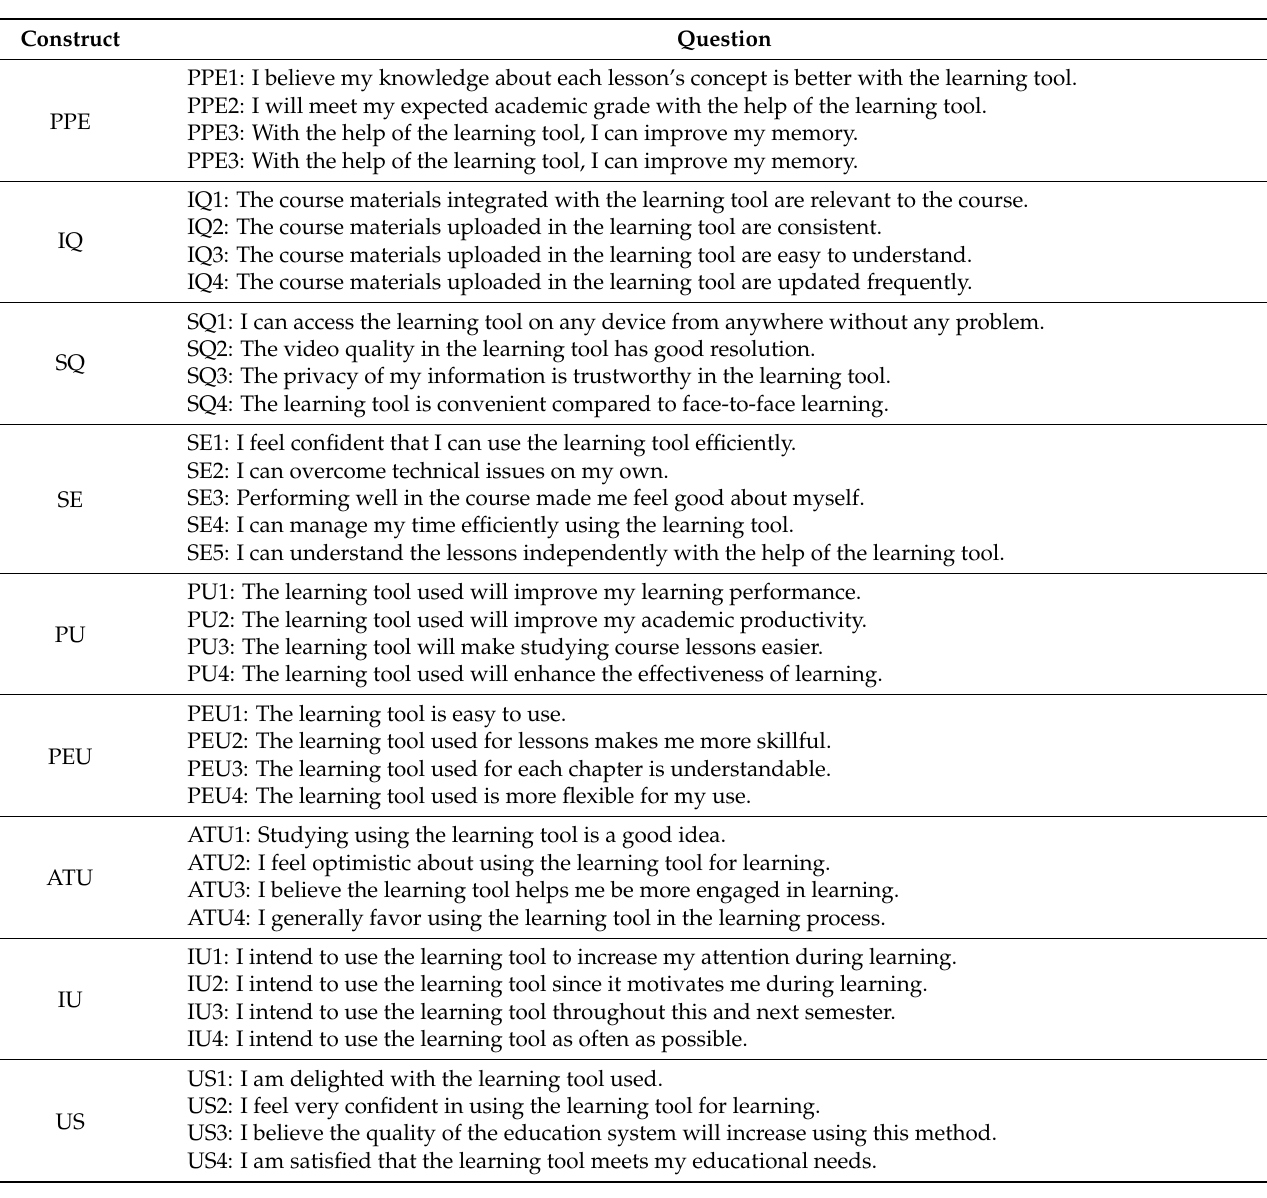
Table A1. Likert-scale questions of the TAM model.